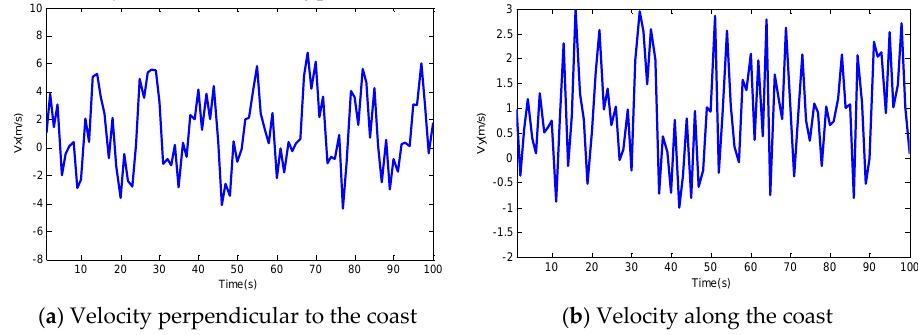
Figure 3. Mobility patterns of an underwater object in a seashore environment.